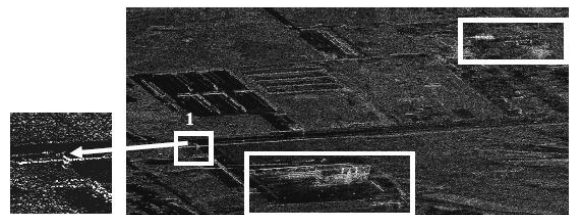
Figure 3 Image after enhanced processing of airborne